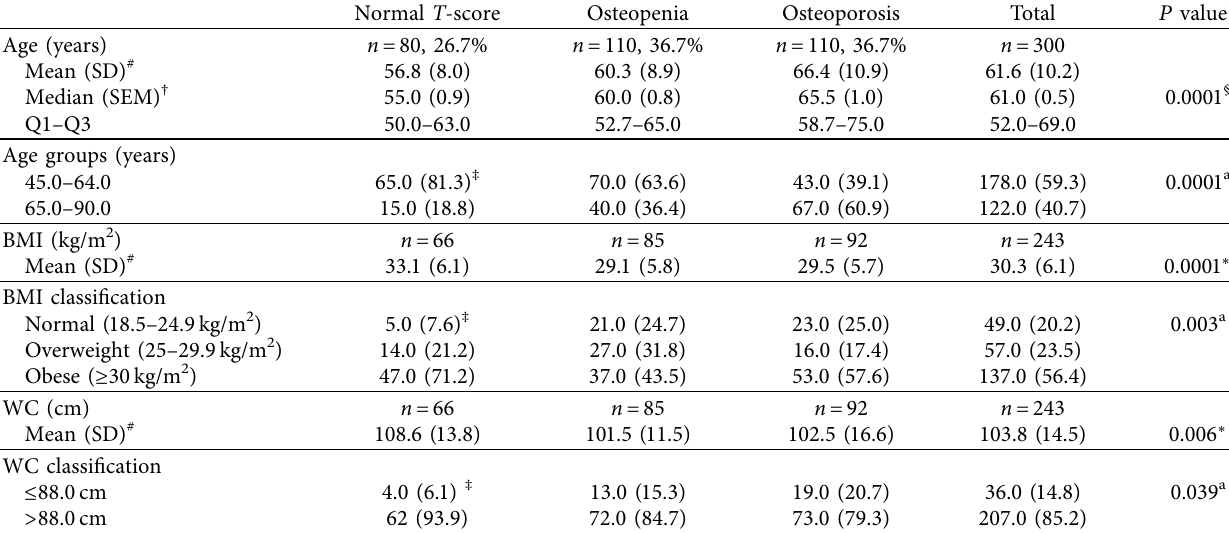
Table 1: Age and anthropometric measurements of normal T -score, osteopenic, and osteoporotic Sudanese